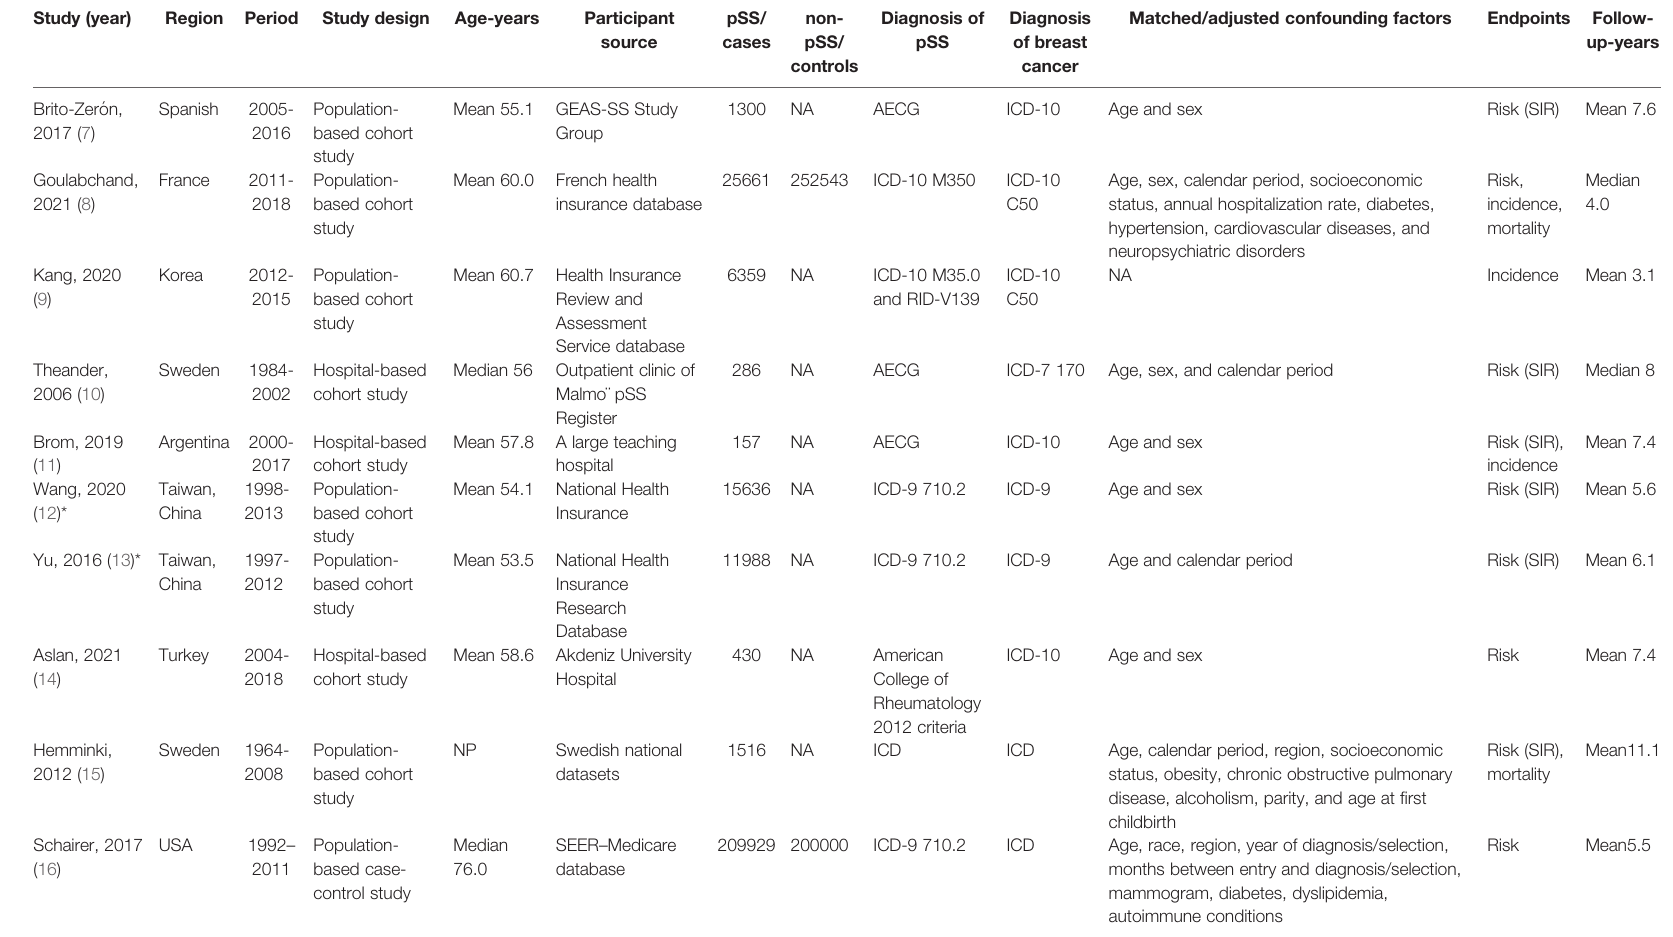
TABLE 1 | Characteristics of included studies.